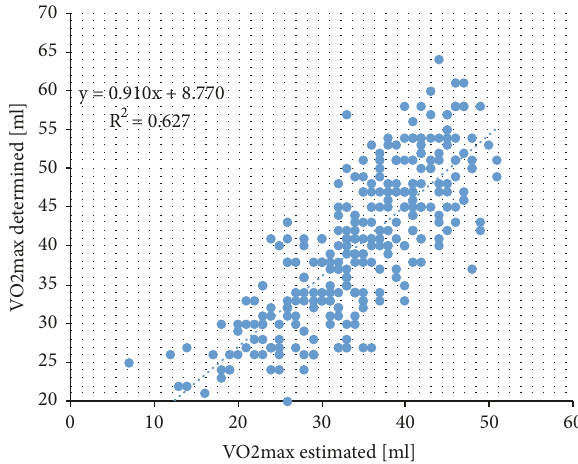
Figure 2: Scatterplot depicting the correlation between VO 2 max determinedby the 20-metershuttleruntest[12] (y-axis) and VO 2 max estimated using the developed regression equation (x-axis). VO 2 max : maximal oxygen